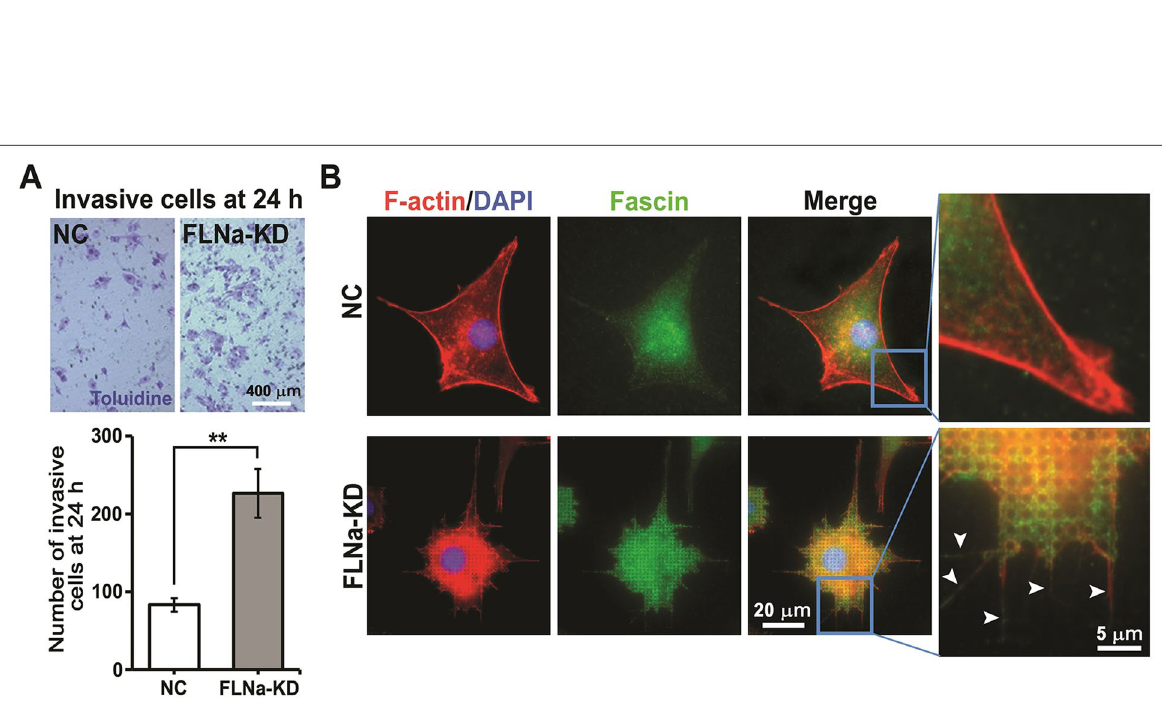
10 4 cells initially seeded × SD of ±